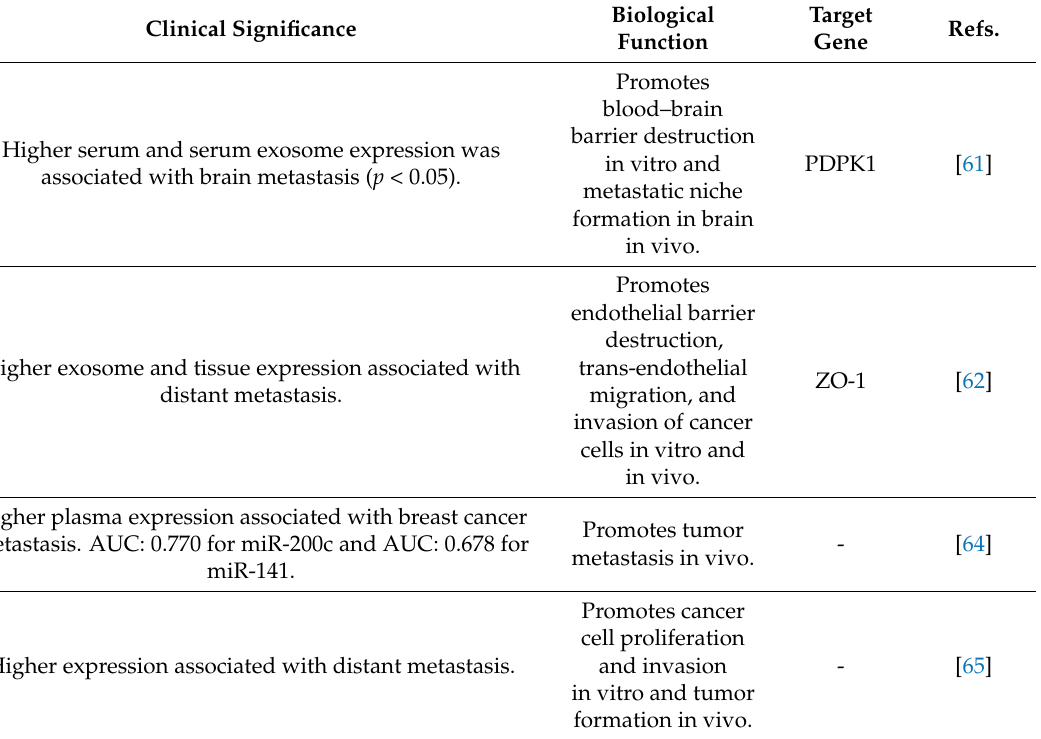
Higher expression associated with distant